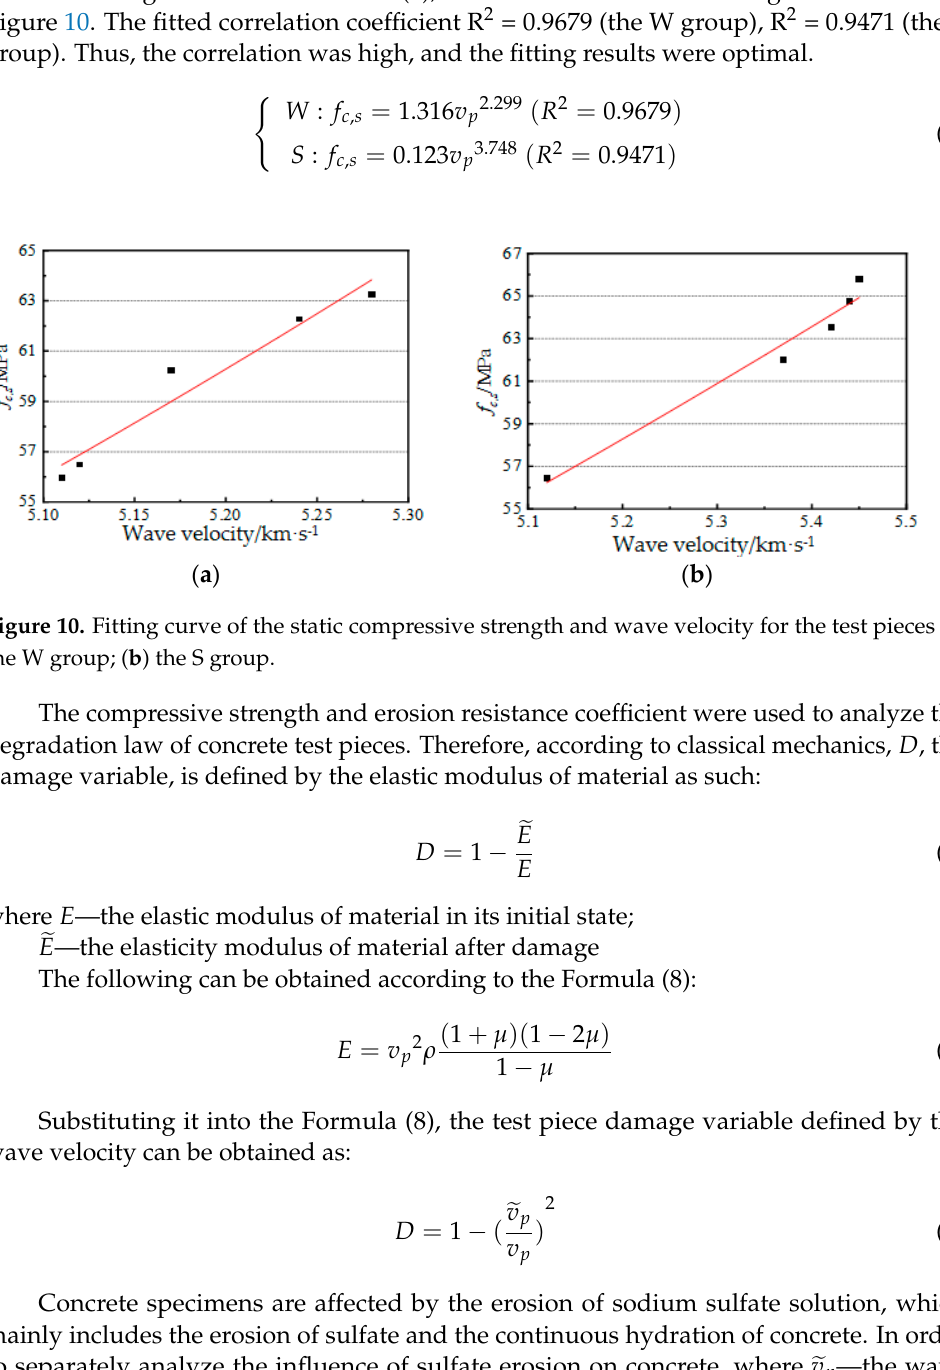
Figure 9. Relationship between longitudinal wave velocity and static compressive strength.